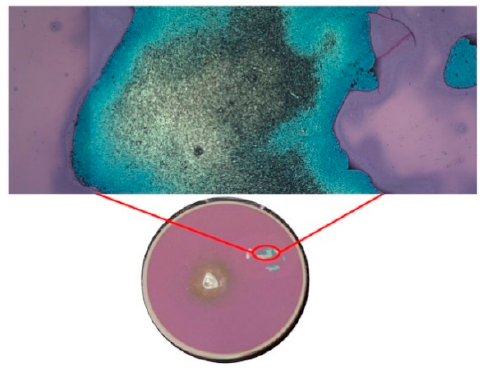
Figure 8. Damage phenomenon of the Ge window with short -pulse laser irradiation.